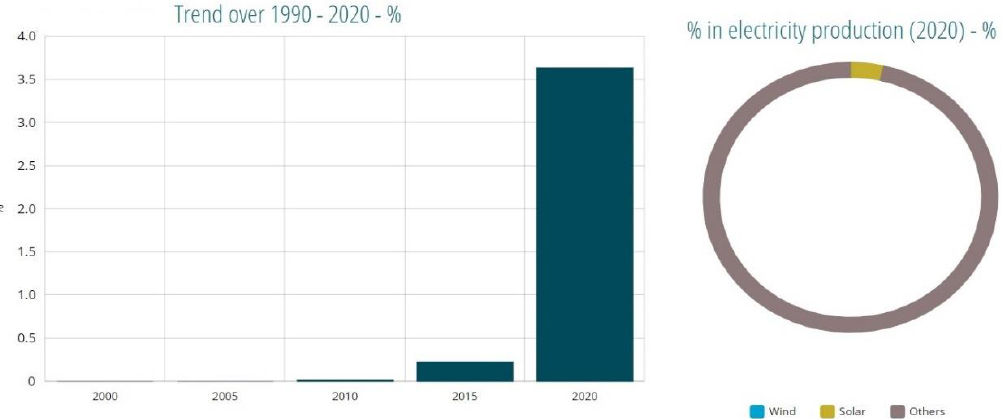
Figure 2. UAE renewable power generation percentage (1990 – 2020) and power generation mix in 2020 [13].